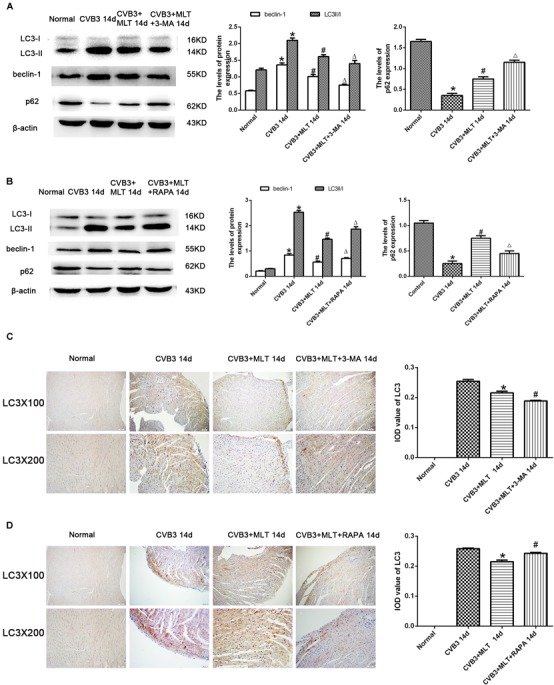
Levels of autophagy in the heart on day 14 (n = 5 in each group). (A,B) Protein expression levels of LC3II/I, Beclin1, and p62 in myocardial tissue of mice in four groups on day 14. (C,D) Immunohistochemistry for LC3 on day 14. ∗P < 0.05 versus the normal group, #P < 0.05 versus the CVB3 group, ∆P < 0.05 versus the CVB3 + MLT group.